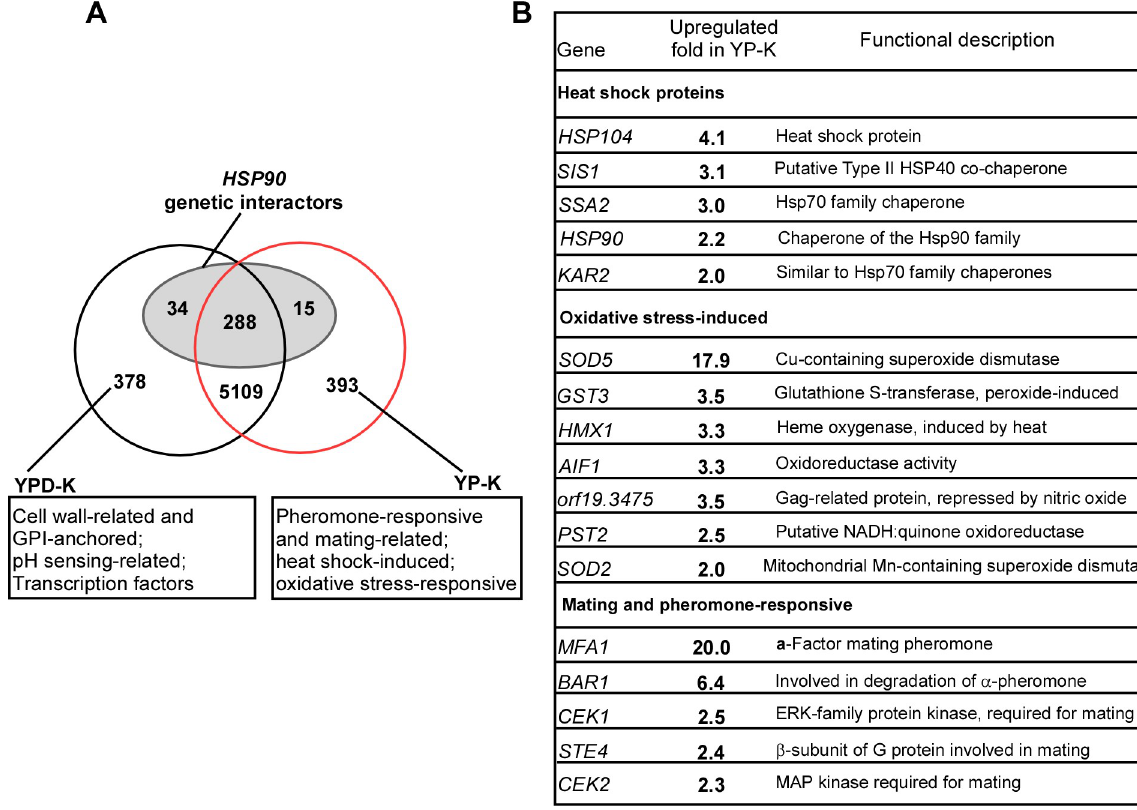
Fig 4. Global gene-expression–profile analysis of C . albicans in the presence and absence of glucose. C . albicans cells were spotted and grown on YPD-K or YP-K media at 25˚C for 60 hours. Total RNA was extracted and used for RNA-Seq assays. To be considered differentially expressed, a gene must satisfy three criteria: (1) an FPKM value higher than or equal to 20 at least in one sample, (2) a fold change value higher than or equal to 1.5, and (3) an adjusted p -value (FDR) lower than 0.05. (A) Venn diagram depicting relationships between differentially expressed genes on YPD-K (412) and YP-K (408) media and HSP90 genetic interactors (indicated in the ellipse). (B) Selected heat-shock-protein–encoding, oxidative-stress–induced, and mating-related genes up-regulated in YP-K medium. AIF1 , Apoptosis-Inducing Factor 1; BAR1 , BARrier 1; CEK1 , Candida ERK-family protein kinase; ERK, ERK-family protein kinase; FDR, false discovery rate; FPKM, fragments per kb per million reads; GPI, glycosylphosphatidylinisotol; GST3 , Glutathione S-transferase; HMX1 , HeMe oXygenase; Hsp90, Heat shock protein 90; KAR2 , KARyogamy; MAP, mitogen-activated protein; MFA1 , Mating type A1; NADH, Nicotinamide adenine dinucleotide; orf19 . 3475 , Candida gene orf19 . 3475 ; PST2 , Protoplasts-SecreTed 1; RNA-Seq, RNA sequencing; SIS1 , Slt4 Suppressor; SOD5 , SuperOxide Dismutase 5; SSA2 , Stress-Seventy subfamily A; STE4 , STErile 4; YPD-K, yeast extract-peptone-glucose-K 2 HPO 4 ; YP-K, yeast extract-peptone-K 2 HPO 4 .